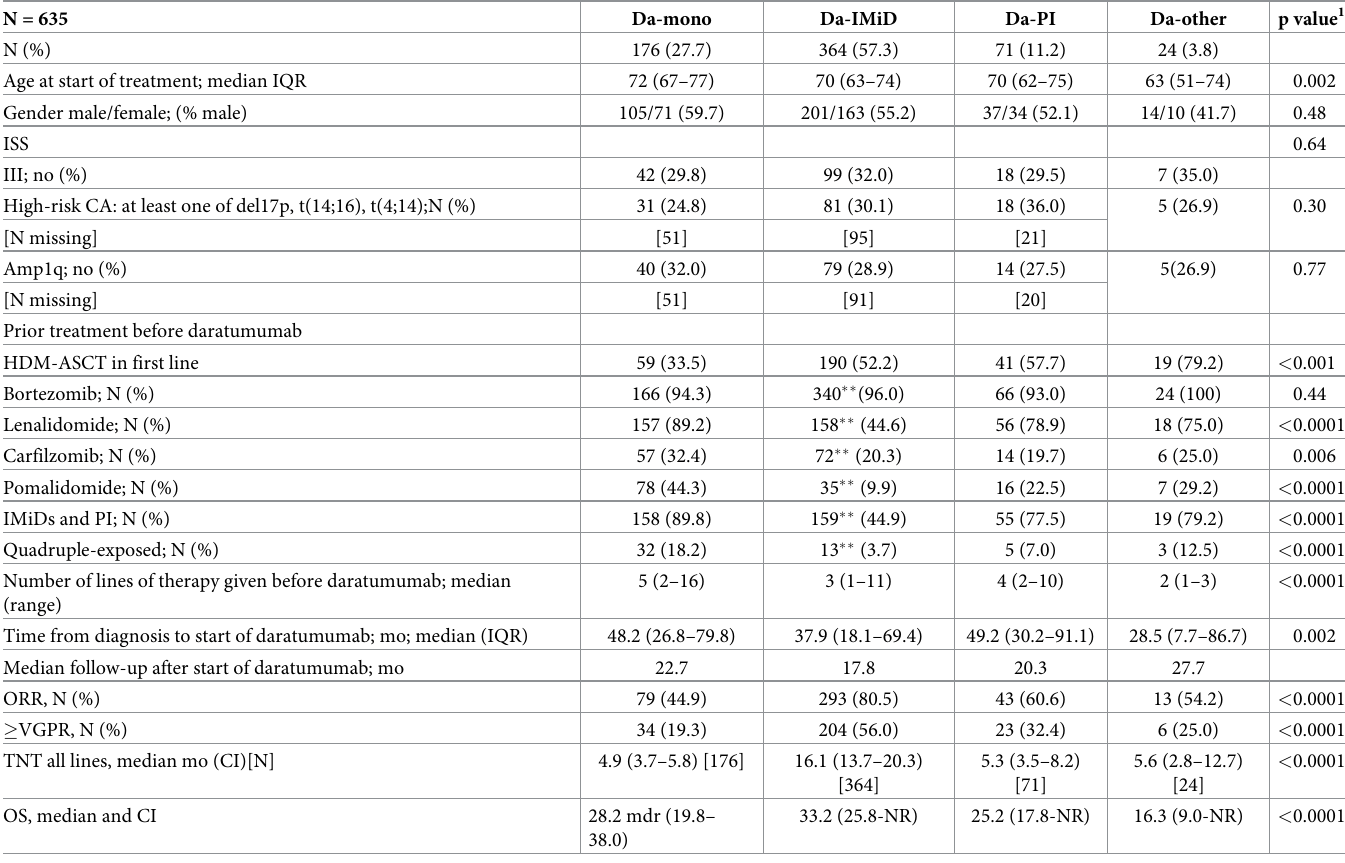
Table 1. Summary of characteristics and outcome of 635 patients treated with